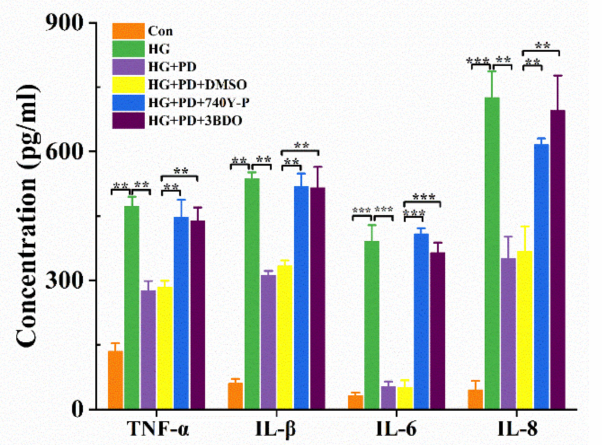
Figure 4. PD downregulated pro-inflammatory cytokines through the PI3K/mTOR pathway. ** p < 0.01, *** p < 0.001. The oral mucosal cells were treated with 740-YP (20 µ M), 3BDO (60 µ M), HG (50 mM), and PD (80 µ g/mL); the concentration of TNF- α , IL-1 β , IL-6, and IL-8 was detected by